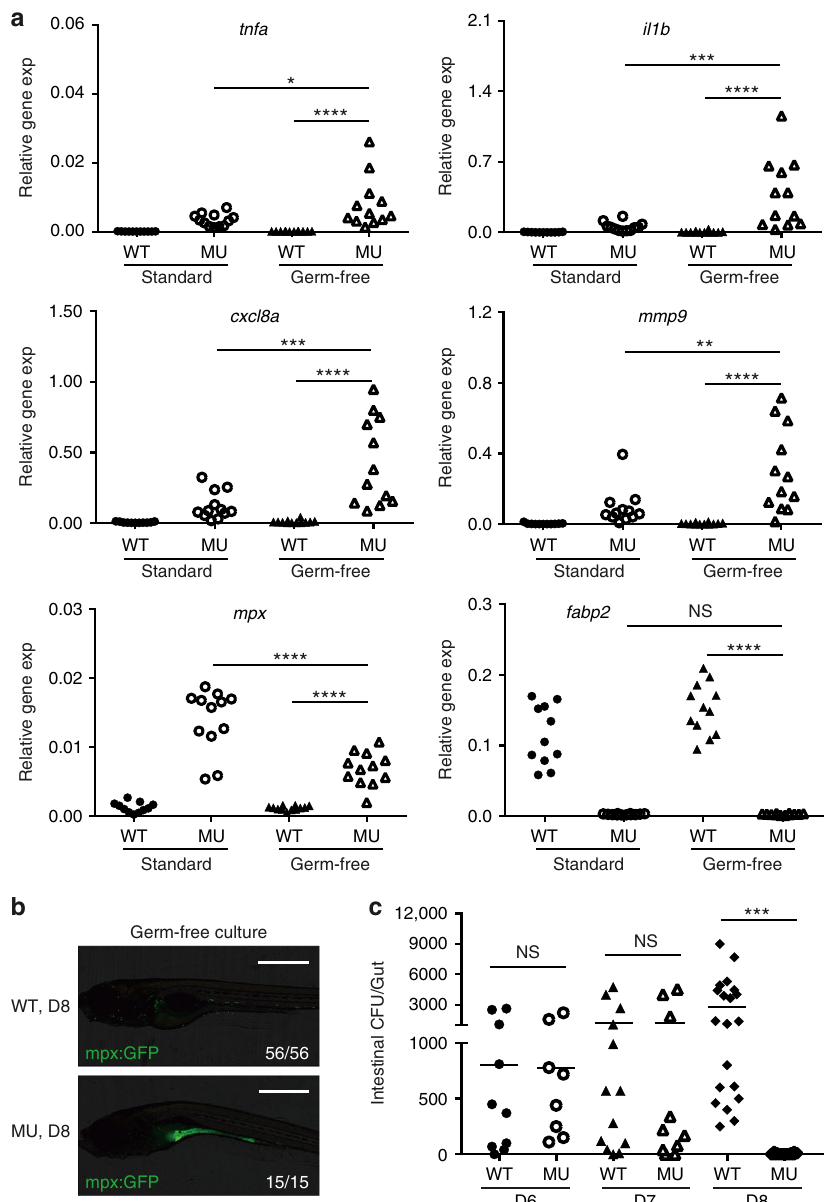
Fig. 4 Intestinal microorganisms are not required for PIK3C3 de fi ciency-induced in fl ammation. a Scatter plots showing the qRT-PCR results of the indicated genes in 8 dpf embryos under either standard or germ-free culture conditions. Each dot represents the mean of three technical replicates from one embryo. In fl ammatory genes are signi fi cantly stimulated in mutants under germ-free culture condition. NS, non-signi fi cant; * p < 0.05; ** p < 0.01; *** p < 0.001; **** p < 0.0001 in one-way ANOVA with Tukey ’ s multiple comparison. b Neutrophils accumulate in the digestive tract of mutant in the absence of gut microbiota. Images were acquired as described in Fig. 3c. c Scatter plot showing the numbers of bacteria in intestinal homogenates from individual embryo at 6, 7, and 8 dpf under standard culture condition. WT and mutants have similar gut bacteria at 6 and 7 dpf. However, the number of gut bacteria becomes either very low (<20 CFU/gut, 5 out of 14 embryos) or undetectable (9 out of 14) in the mutants at 8 dpf, which is signi fi cantly reduced when compared to that in wild type siblings (NS, non-signi fi cant; *** p < 0.001 in one-way ANOVA with Tukey ’ s multiple